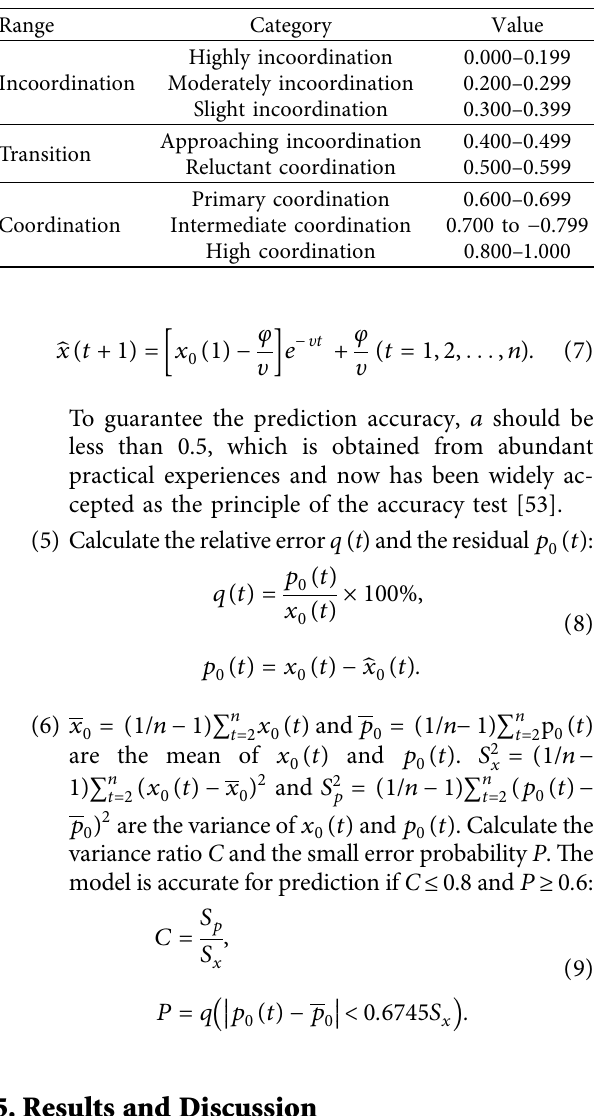
Table 3: Category of